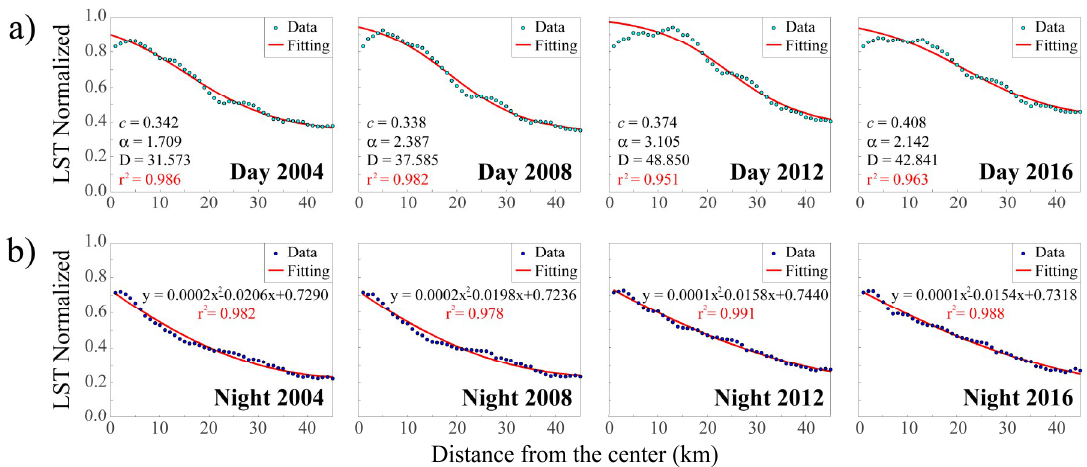
Figure 7. Fitting of the mean LST n data as a function of the city center distance. The r 2 is also reported. ( a ) daytime: Inverse S-shape function and correspondent parameters c , α, and D .; ( b ) night-time: Quadratic function.